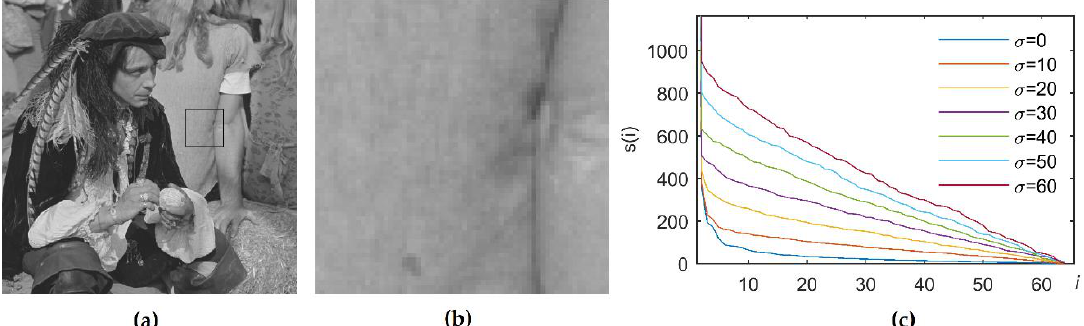
Figure 1. ( a ) Test image “Pirate”. An example image block of size 64 × 64 is outlined; ( b ) The example image block is magnified; ( c ) Singular value curves corresponding to the example image block at various noise levels.